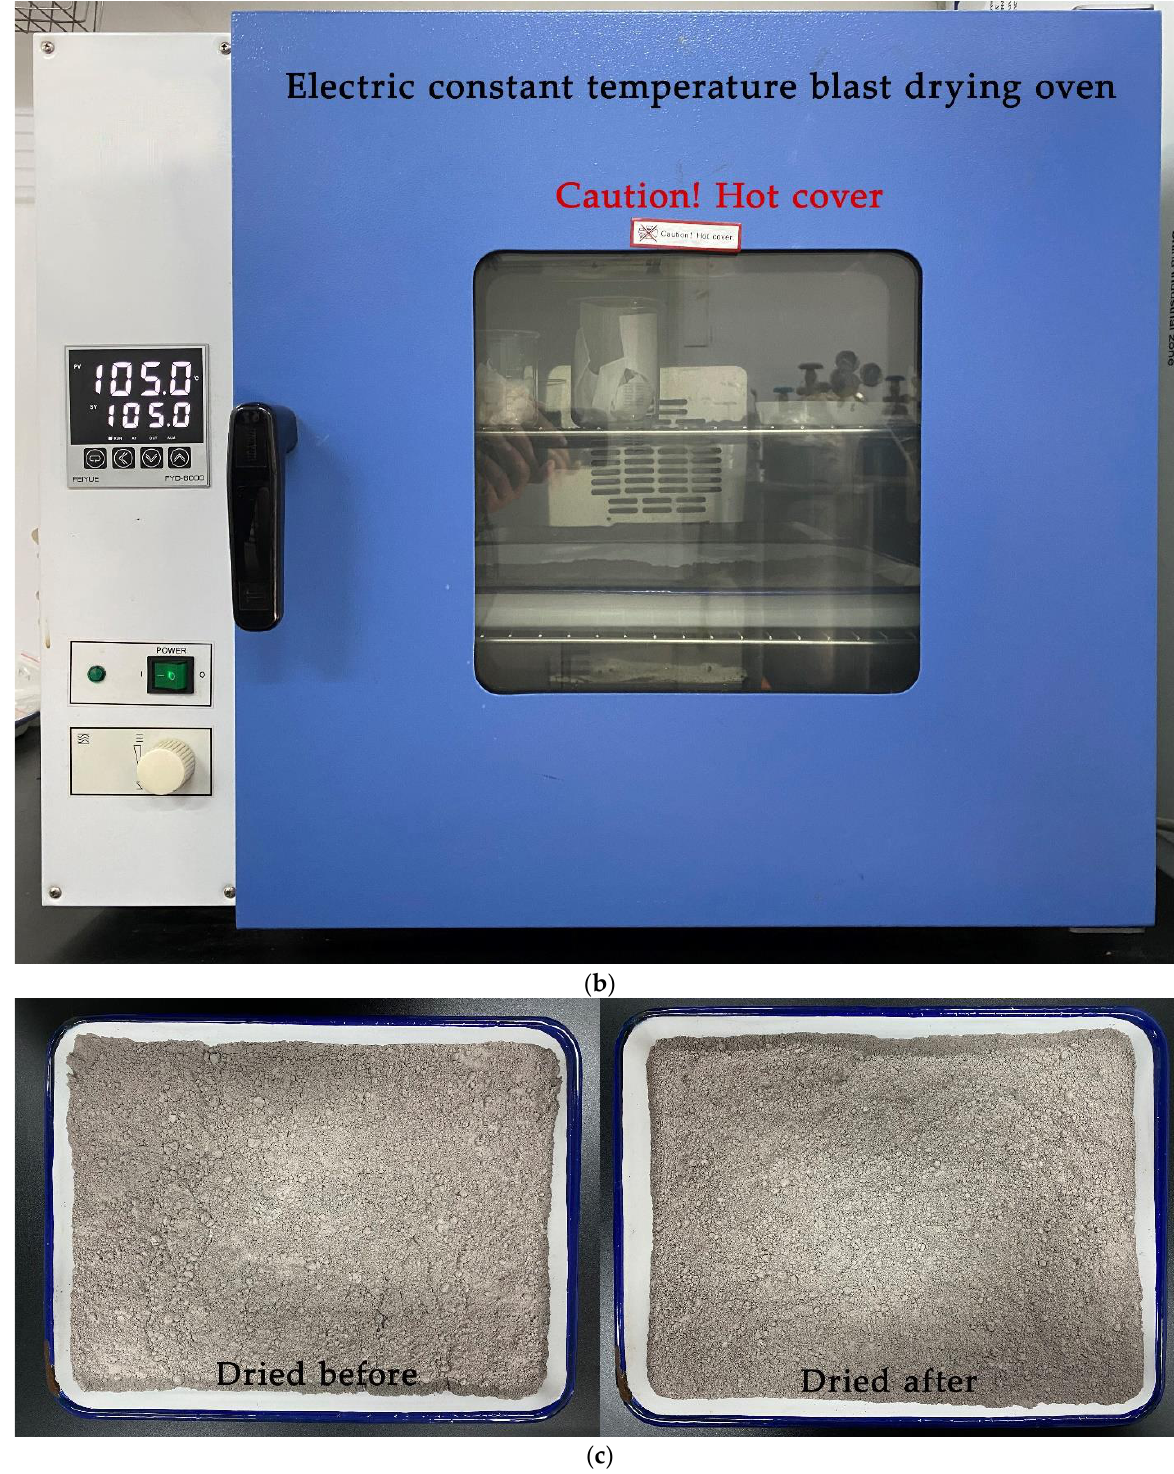
Figure 5. Fly ash drying process. ( a ) Tray size. ( b ) Electric constant temperature blast drying oven. ( c ) The comparison of dried before and dried after fly ash. ( c ) The comparison of dried before and dried after fly